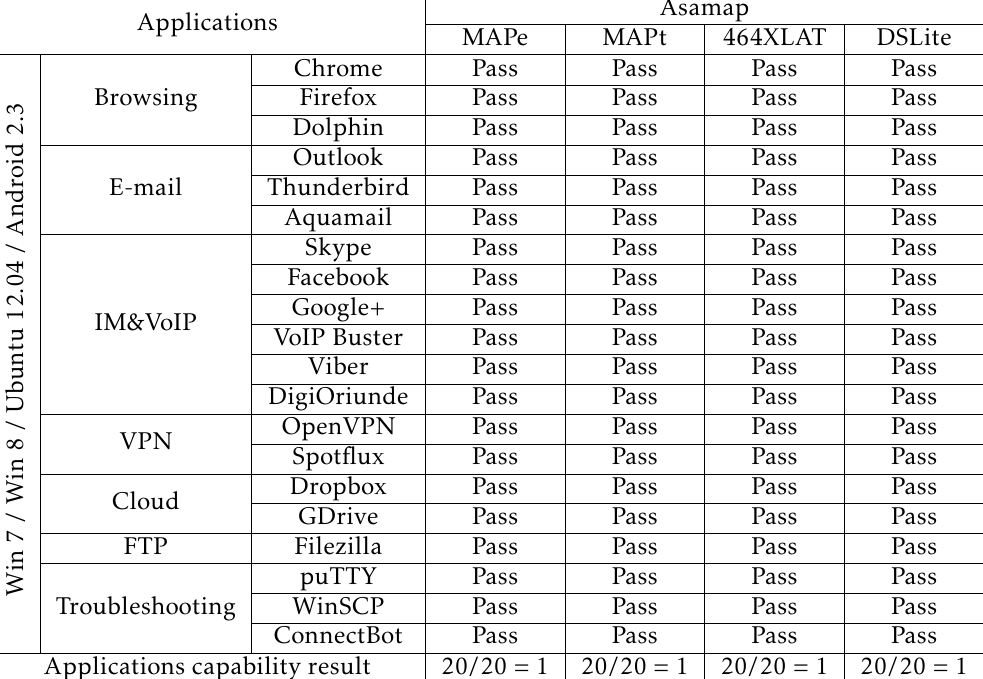
Table 6. Applications capability